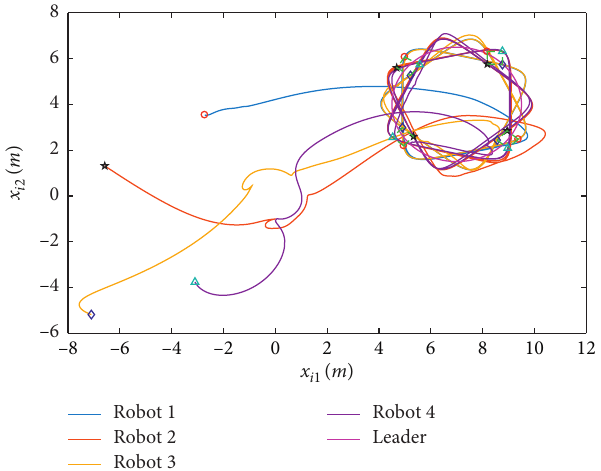
Figure 7: Task-space time-varying formation tracking perfor- mance of the NHRS shown in the XY plane in Example 1.